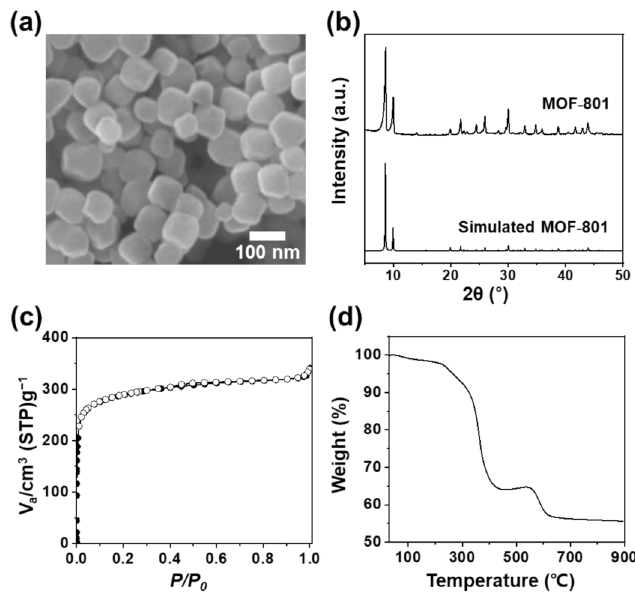
Figure 1. Characterization of the synthesized MOF − 801: ( a ) SEM image, ( b ) XRD pattern, ( c ) nitrogen adsorption/desorption isotherm, and ( d ) TGA